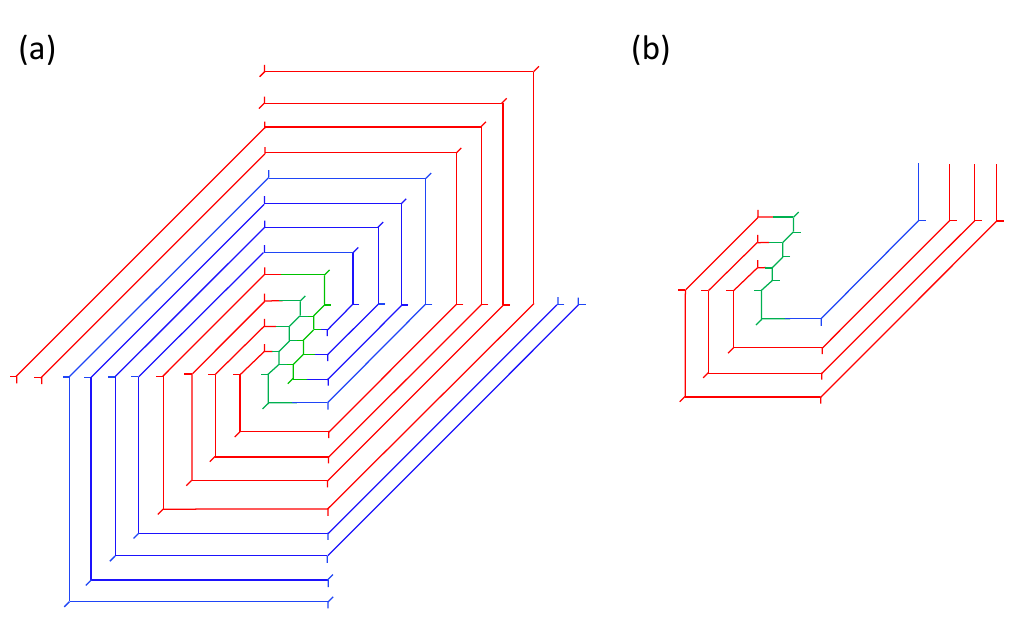
Figure 1 . (a) The Tao diagram corresponding to the 5d N = 1 SU(3) gauge theory with 10 flavors whose spiral structure continues infinitely. (b) Its building block.